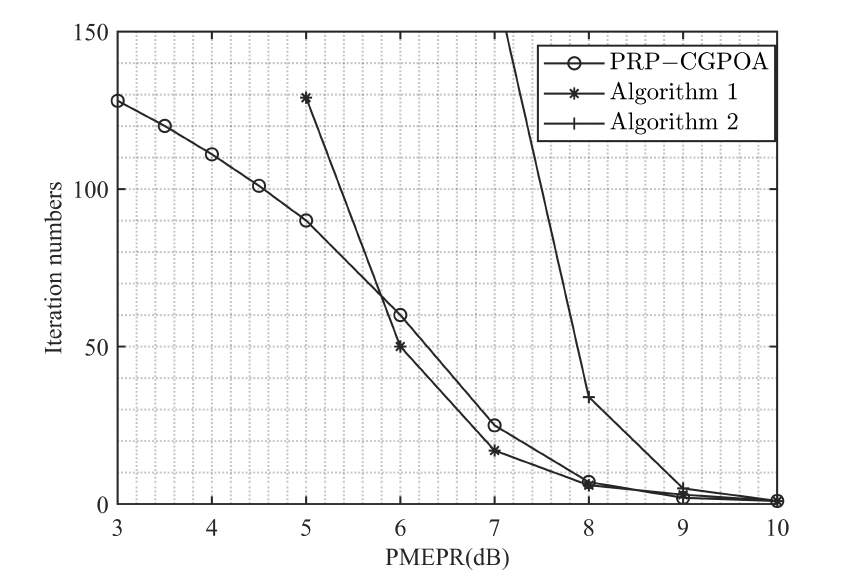
Figure 6. Iteration numbers in complexity analysis versus achieved PMEPR, where Algorithm 1 is from [19] and Algorithm 2 is from